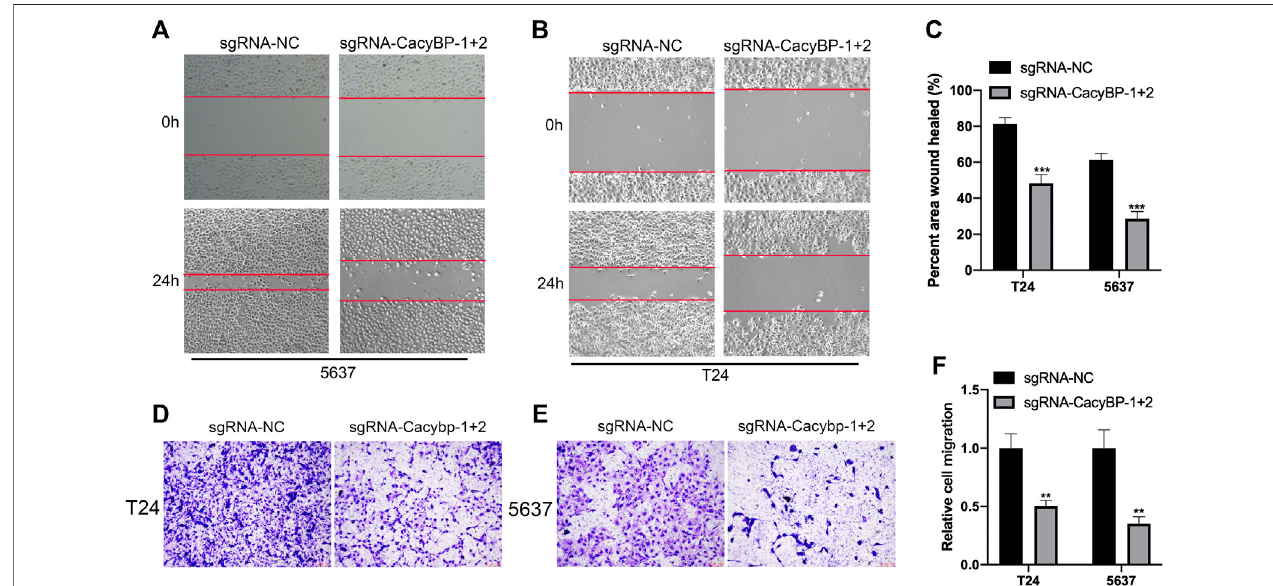
FIGURE4| DownregulationofCacyBPinhibitedthemigrationofbladdercancercells (A – C) Wound-healingassaysformigrationabilityofT24and5,637cellsafter transfected with dCas9-KRAB and sgRNAs (D – F) Transwell assays for migration ability of T24 and 5,637 cells after transfected with dCas9-KRAB and sgRNAs. ** p < 0.01, *** p < 0.001.